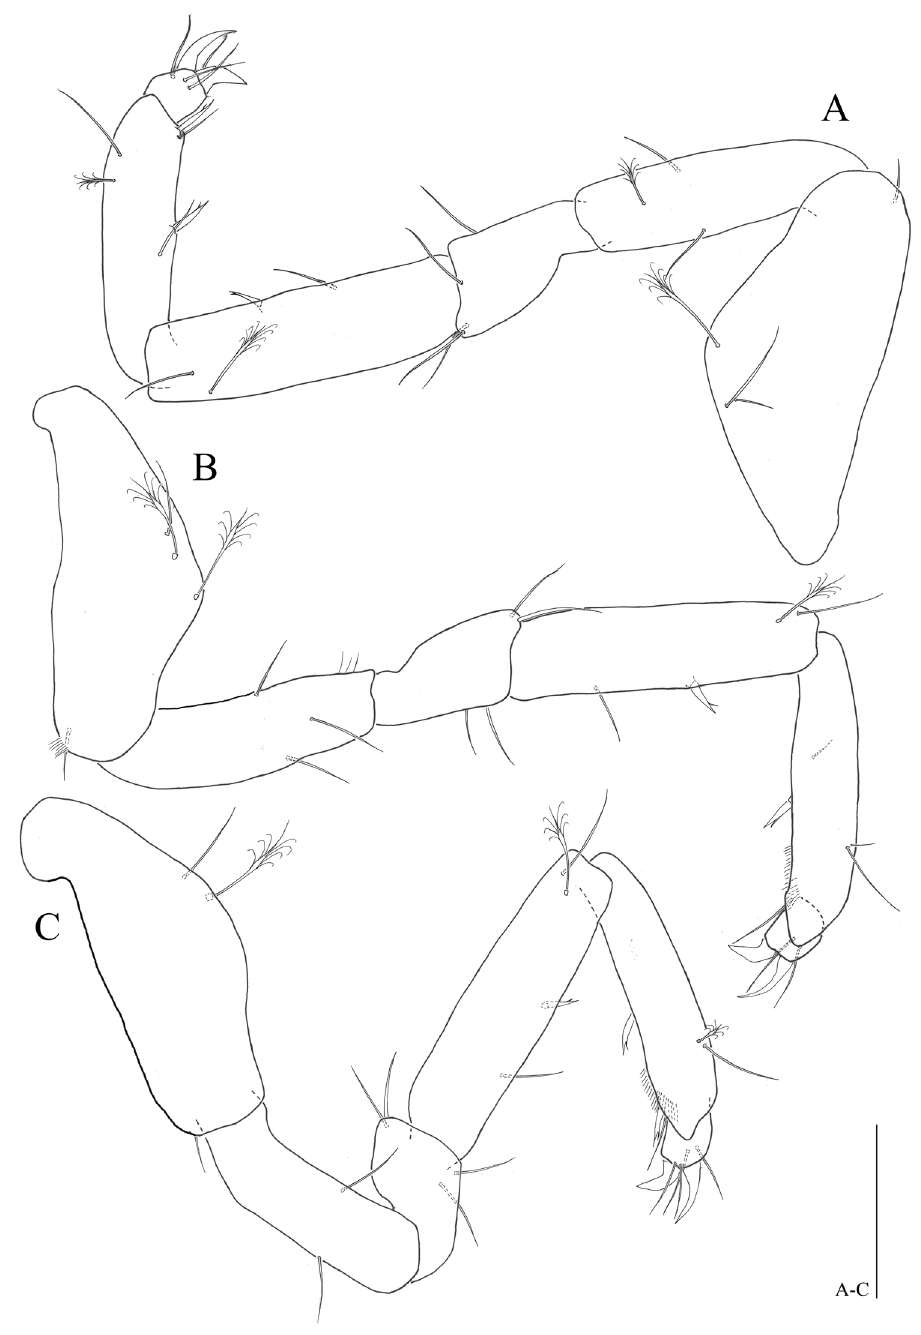
Figure 5. Microcharon tanakai sp. n., holotype, female. A pereopod 3, lateral B pereopod 4, lateral C pereopod 5, lateral. Scale bars